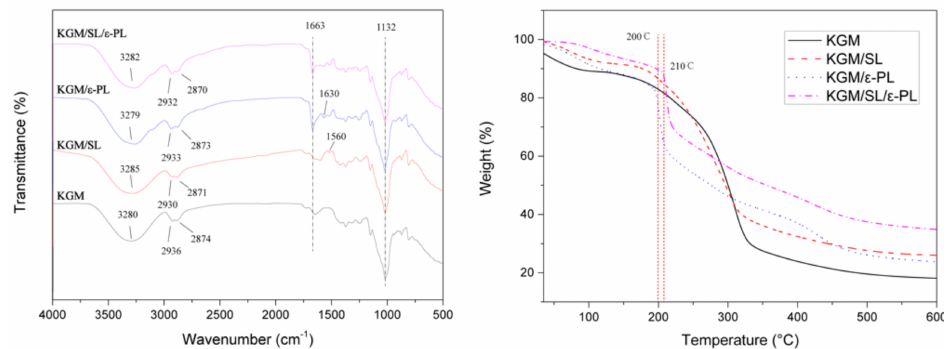
Figure 4. FITR and TGA curves of KGM (KGM 1%), KGM/SL (KGM 1%, SL 0.2%), KGM/ ε -PL (KGM 1%, ε -PL 0.375%) and KGM/SL/ ε -PL (KGM 1%, SL 0.2%, ε -PL 0.375%)